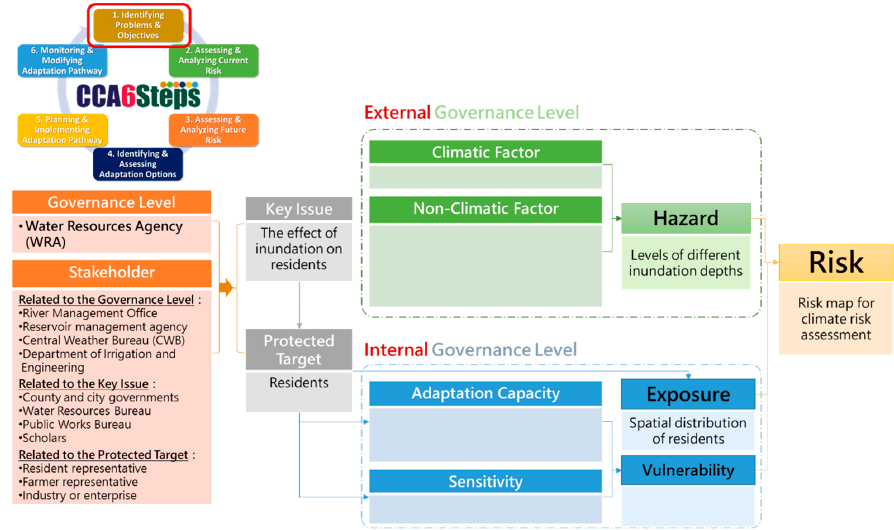
Figure 6. The proposed algorithm of climate risk assessment for investigating the relationship between factors based on Step 1 of CCA6Steps. factors based on Step 1 of